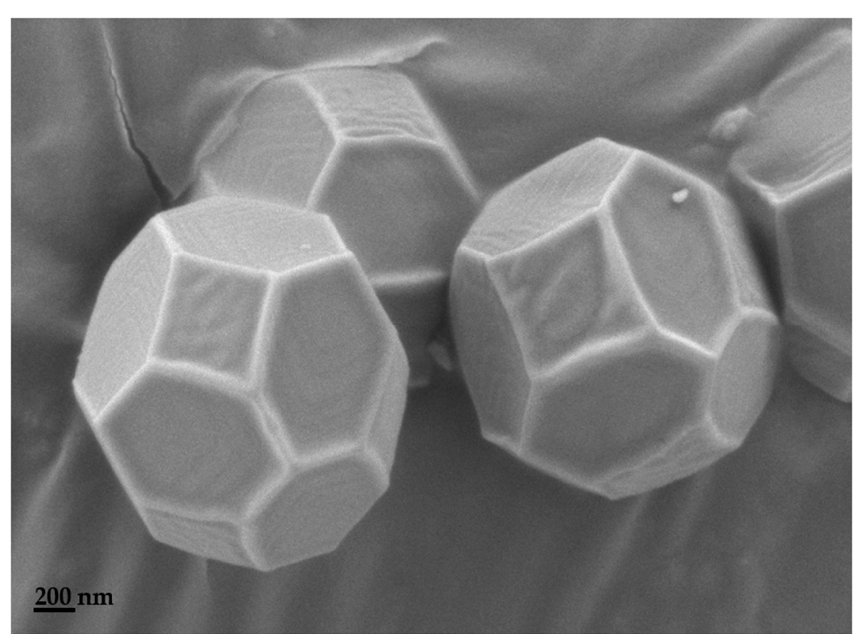
Figure A1. XRD pattern of ZIF-67.